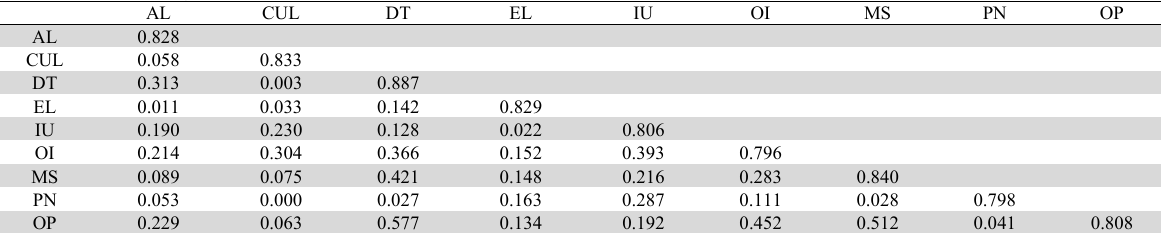
Discriminant validity (Fornell & Larcker, 1981a) AL